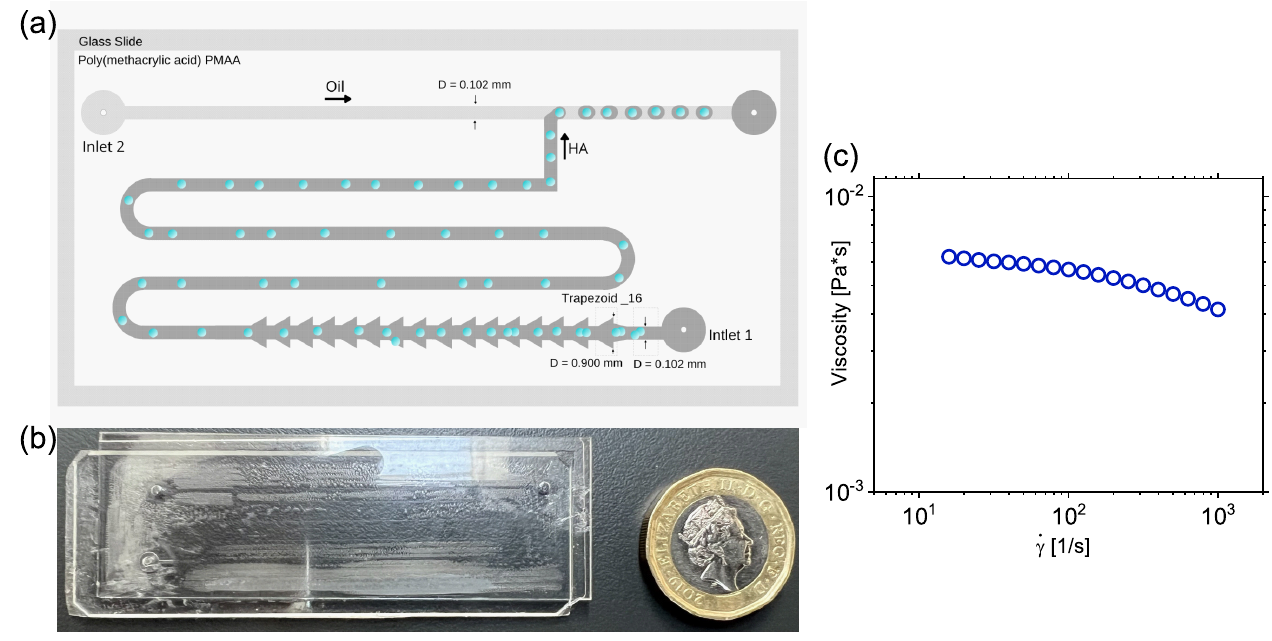
Figure 1. ( a ) Schematic representation of the T − junction device employed in this work. The dis- persed viscoelastic phase entered the device via Inlet 1. The trapezoidal structures were added in order to break down potential particle aggregates, in agreement with previous works [43]. After the trapezoidal structure, particles first aligned on the channel centreline and then self-ordered before approaching the encapsulation area. The continuous phase entered the device via Inlet 2, and the droplets containing flowing particles were formed at the T − junction. ( b ) Image of the Microfluidic device employed in this study next to a 1 pound coin. The device was made of Polymethylemethacry- late bonded on a glass slide using a double − sided tape (see main text for more details) ( c ) Shear viscosity η as a function of the shear rate ˙ γ for the hyaluronic acid solution at 0.1 wt% in phosphate buffer saline. The solutions displays shear − thinning properties above a value of the shear rate equal to ˙ γ (cid:39) 30 s − 1